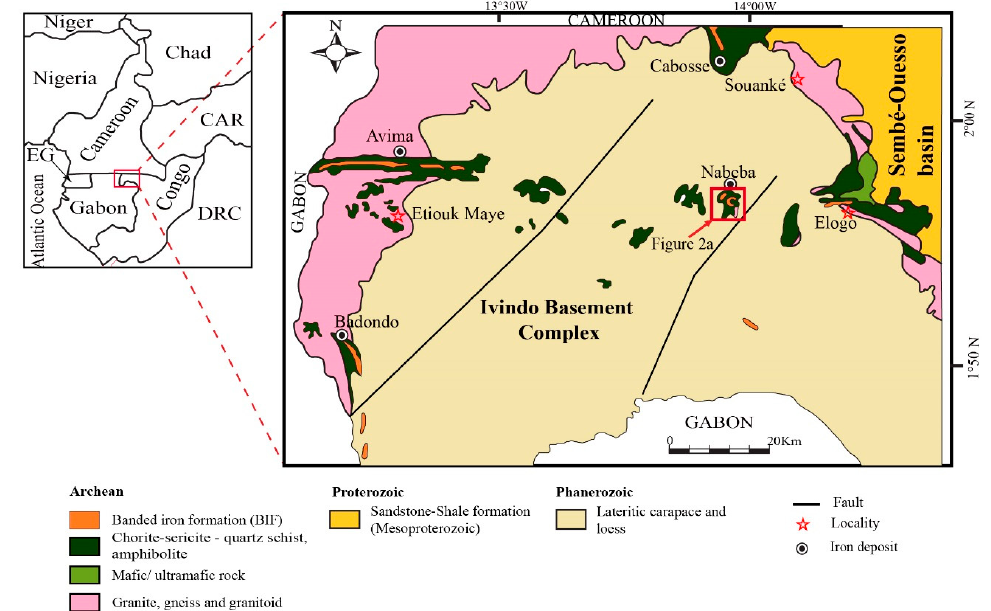
Figure 1. Regional geology of the northwestern Republic of Congo (modified after Minist è re des mines et de l’ é nergie; Direction G é n é rale des mines [11] and Desthieux [12]). Abbreviations: CAR, Central African Republic; DRC, Democratic Republic of the Congo; EG, Equatorial Guinea.